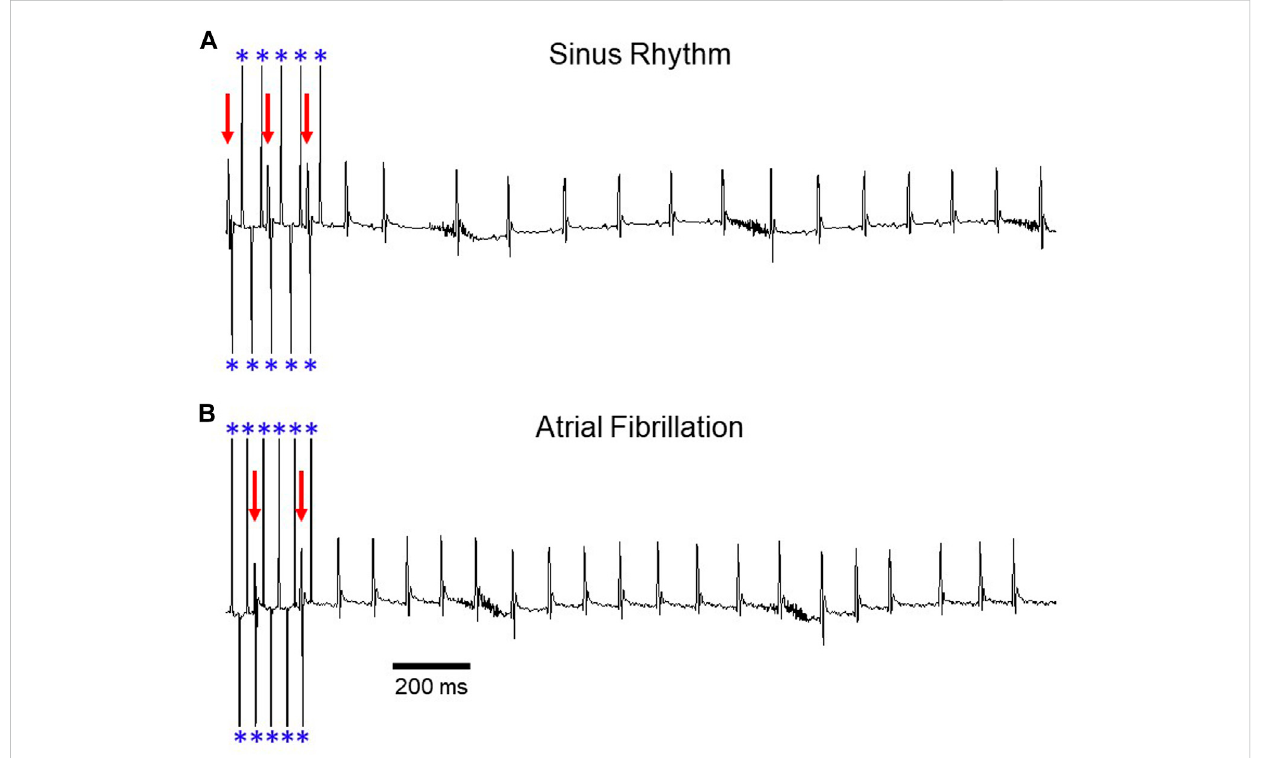
FIGURE 1 Induction of AF during transesophageal atrial pacing. Surface ECG recordings depicting (A) sinus rhythm and (B) atrial fi brillation after rapid atrial pacing. In panel A , pacing demonstrates 2:1 AV conduction(rate exceeds Wenckebach cyclelength),with variable A:Vconduction in panel B . Red arrows denoteQRScomplexesandblueasterisksdenoteatrialpacingspikes.Thebaselineartifactisrelatedtomouserespiration.AdaptedfromMurphyMB,Kim K,KannankerilPJ,MurrayKT.OptimizationofTransesophagealAtrialPacingtoAssessAtrialFibrillationSusceptibilityinMice. JVisExp .(184),e64168, doi:10.3791/64168 (2022).